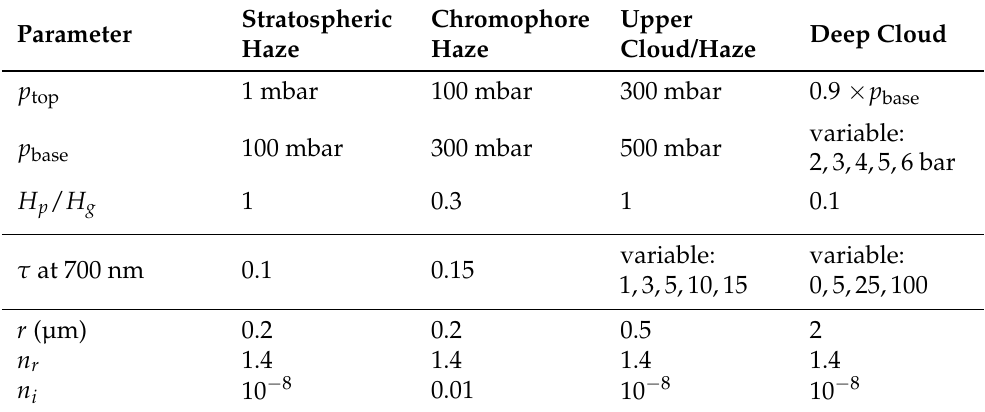
Table 2. Aerosol model framework and key parameters. Opacity in each layer is bounded between p top and p base , distributed following the particle-to-gas scale height ratio H p / H g . Particle sizes follow gamma distributions with variance 0.1 and mean particle sizes as listed in the table. Particles are modeled as Mie scatterers with indices of refraction n r + in i . Particles with n i ≤ 10 − 8 behave as conservative scatterers, with numerical stability provided by n i >